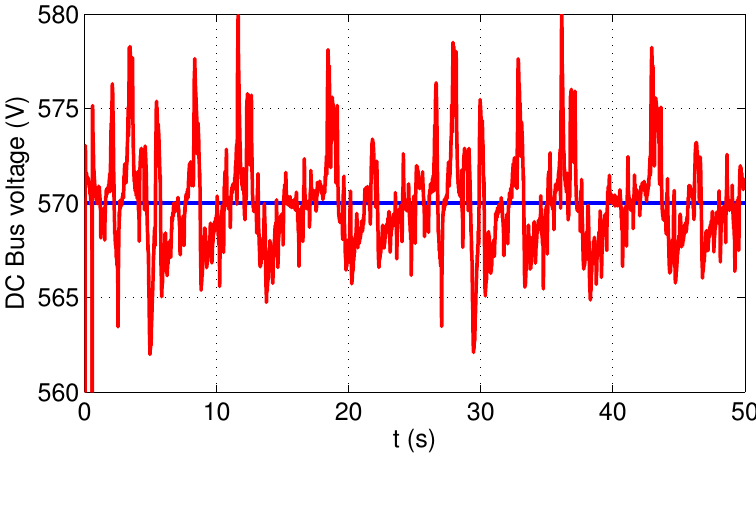
Figure 14. Wind speed step